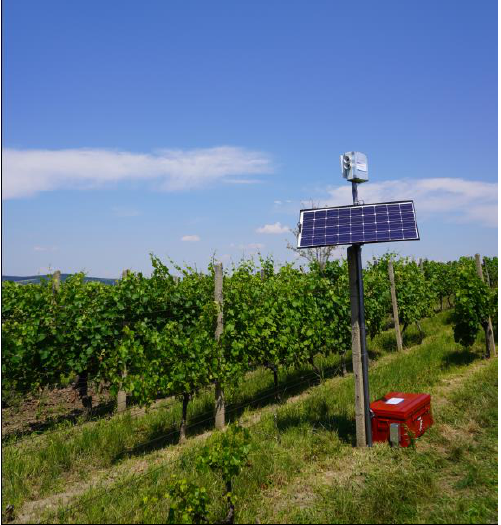
Figure 3. The complete setup located at a vineyard in Bořetice, Moravia, the Czech Republic.